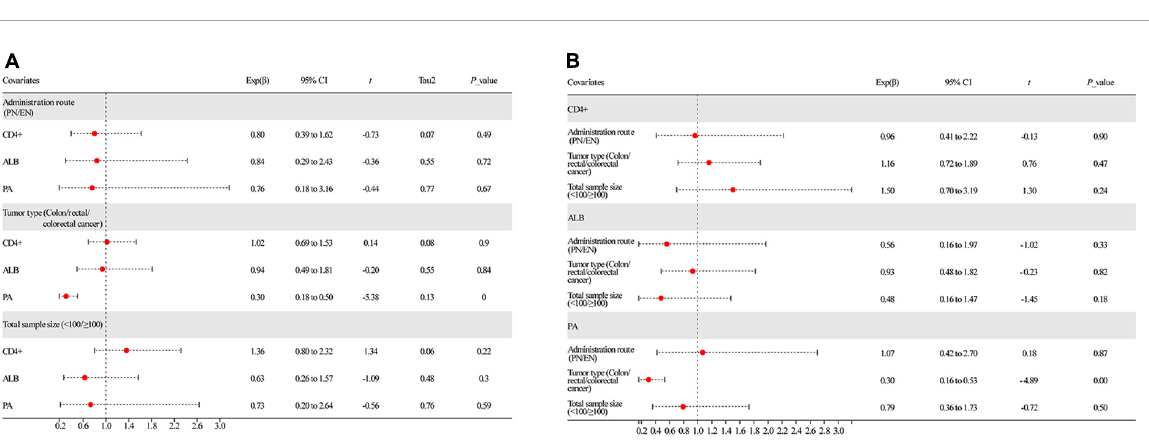
for decreasing the production of pro-inflammatory cytokines (59). They improve the nutritional level of patients, thereby improving the cachexia caused by cancer and the quality of